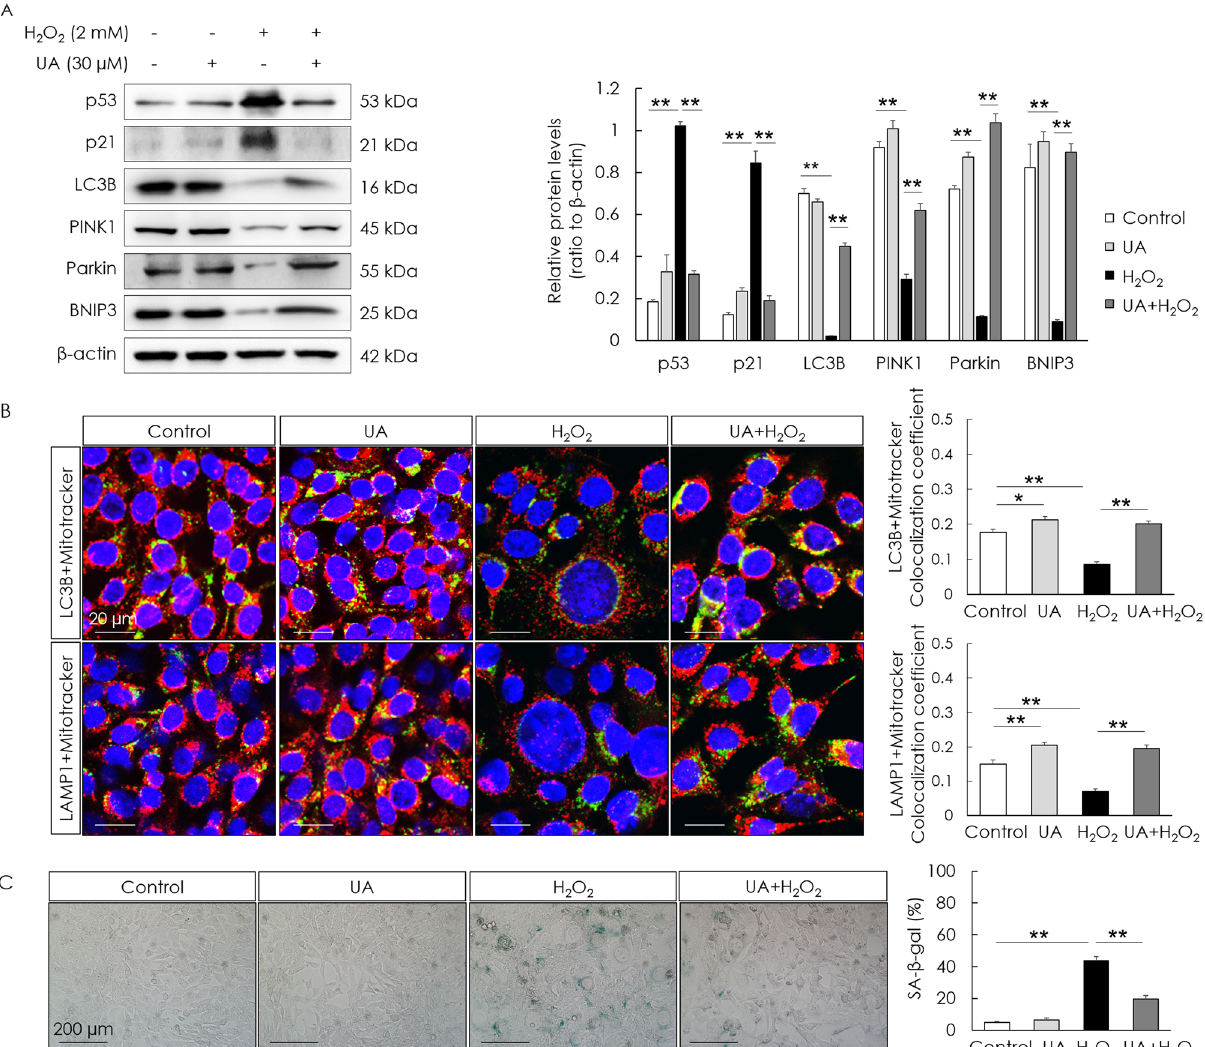
Figure 3. Effect of UA on levels of senescence and mitophagy in HEI-OC1 cells. HEI-OC1 cells were pre- treated with 30 µM UA for 2 h, and then incubated with or without 2 mM H 2 O 2 for 1 h, and incubated in culture medium for 5 days. UA pre-treatment significantly decreased the levels of senescence-associated proteins (p53, p21) and significantly increased the levels of mitophagy-related proteins (PINK1, Parkin, and BNIP3) following H 2 O 2 treatment of HEI-OC1 cells ( A ). Mitophagosomes were detected using co-localization (yellow puncta) of LC3B (green) and MitoTracker (red) (B, upper panel). Mitophagolysosomes were detected using co-localization (yellow puncta) of LAMP1 (green) and MitoTracker (red) (B, lower panel). The co-localization areas of LC3B and MitoTracker, and LAMP1 and MitoTracker were significantly reduced in H 2 O 2 -treated cells, whereas they were significantly enhanced in UA-pre-treated cells ( B ). UA pre-treatment significantly decreased the percentage of β-gal-stained cells following H 2 O 2 treatment of HEI-OC1 cells ( C ). Data are presented as means ± standard errors of the mean of five independent experimental results (UA, Urolithin A; SA-β-gal, senescence associated- beta galactosidase). * p < 0.05, ** p < 0.01. The grouping of gels/blots cropped from different parts of the same gel. Full-length blots are presented in Fig.